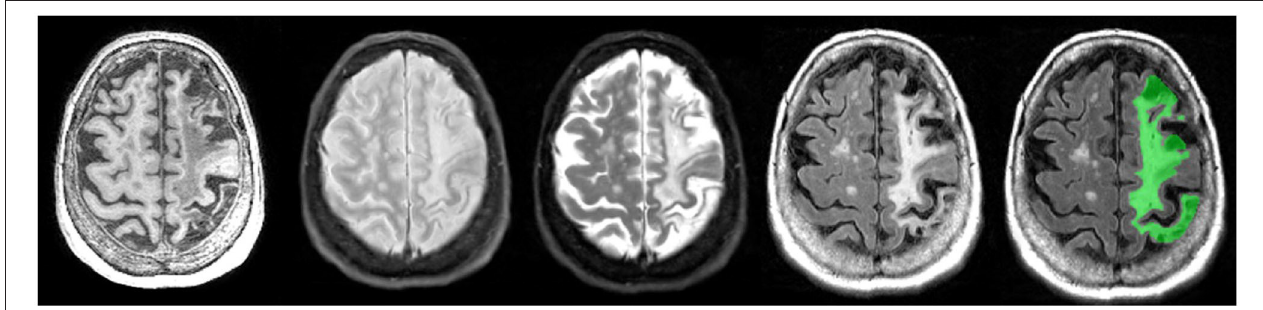
FIGURE 12 | Axial view of coregistered structural MRI sequences (left to right): T1, PD, T2, and FLAIR. Images illustrate relative intensity differences of a large cortico-subcortical stroke lesion across various types of MRI. The last pane shows ONDRI’s manual segmentation of the entire stroke core and surrounding hyperintense partially infarcted tissue volume in green.